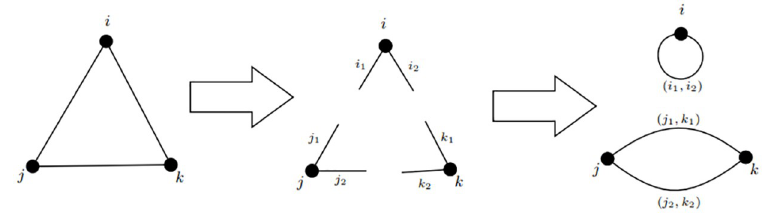
Fig 2. Configuration model